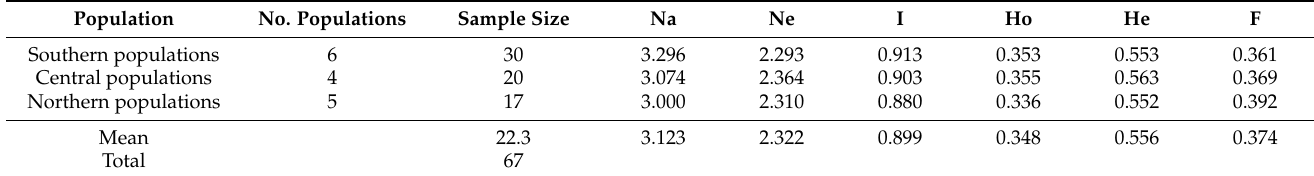
Table 4. Results of microsatellite analysis for group of maize populations per region.